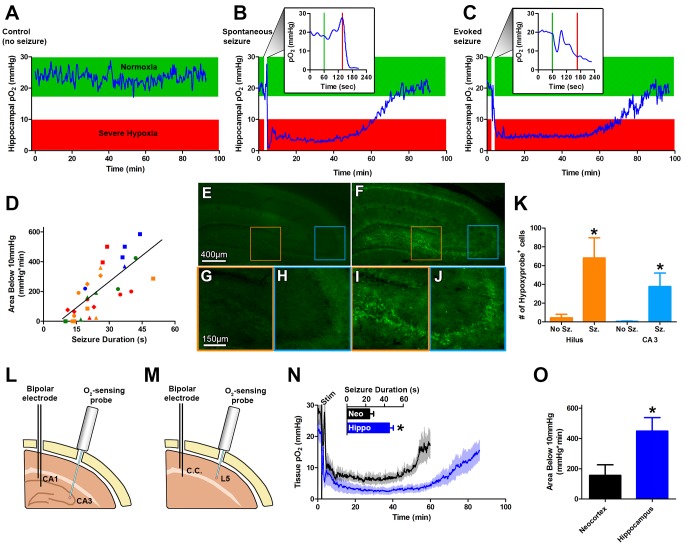
Seizures induce severe postictal hypoxia.(A) Local tissue oxygenation in the hippocampus of an awake, freely-moving rat (blue). Green denotes normoxia while red denotes severe hypoxia. (B) Representative oxygen profile before, during, and after a spontaneous seizure. The inset expands the time-scale during the seizure with the green and red lines denoting the beginning and end of an 80 s seizure. This inset corresponds to the white vertical block near the beginning of the full oxygen recording. (C) Representative oxygen profile before, during, and after a 106 s electrically kindled seizure. (D) Scatterplot of the relationship between the duration of kindled seizures in the dorsal hippocampus (primary afterdischarge) and the degree of severe hypoxia expressed as the total area below the severe hypoxic threshold (10.0 mmHg) by time (min). Symbols with both the same colour and shape are from the same animal (n = 14). The line of best fit (y = 11.85x+7.57) is indicated. R square = 0.55, p<0.0001. (E–J) Hypoxyprobe immunohistochemistry. (E) Representative image from control rat with close-ups of CA3 (H) and hilus (G). (F) Representative image following a seizure with close-ups of CA3 (J) and hilus (I). Scale bar for (E,F) = 400 µm. Scale bar for (G–I) = 150 µm. (K) Densely stained neurons in the hilus and CA3 were quantified. There are significantly more stained cells in the hilus and CA3 following seizures. Data are mean ± SEM. *p<0.05 (t-test). (L–N) Comparing hippocampus and neocortex. (L) Location of chronic hippocampal implants. (M) Location of chronic neocortical implants. Bipolar electrodes were used for stimulating and recording seizure and O2 sensors for continuous oxygen recordings. C.C. is corpus callosum, L5 is layer 5. (N) Inset displays mean seizure duration ±SEM (n = 5). Hippocampus had significantly longer seizures. *p<0.05. The mean pO2 (opaque) ±SEM (transparent) over time recorded in motor neocortex dorsal hippocampus. (O) Quantification of (N). Hypoxia was more severe in the hippocampus relative to neocortex as assessed by the area below 10mmHg. *p<0.05 (t-test).